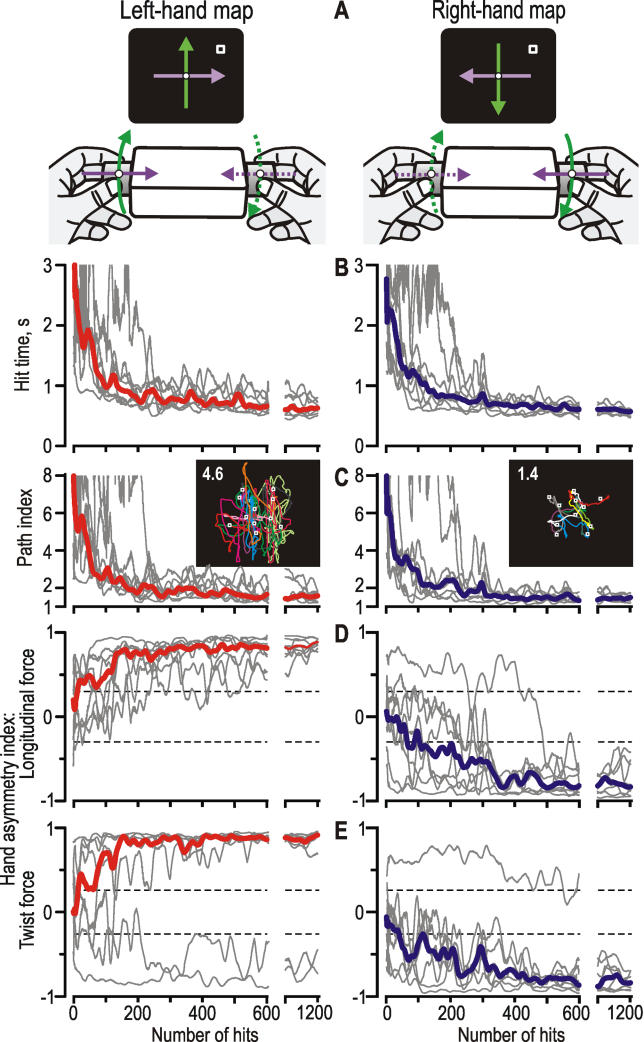
The Bimanual Target-Chasing Task and Flexible Role Assignment of the Hands(A) Mappings between applied forces and cursor movements (top graph). With the left-hand map, the cursor moved horizontally in the direction of the longitudinal force applied by the left hand (solid purple arrows). A counter-clockwise twist force applied between the handles (as if unscrewing the lid of a jar) moved the cursor upward (solid green arrows). With the right-hand map the cursor moved in the opposite directions and thus in the direction of the forces of the right hand.(B and C) Performance under each mapping rule shown for a complete first session with 602 hits and from the last 100 hits of a second session. Superimposed thin lines show hit time and path index for each participant as a function of target number (data median-filtered over a ± 10-s period around each hit). Solid curve give medians across participants. Inserts in (C) exemplify cursor trajectories with a median path index of 4.6 and 1.4 across 10 target transitions. The targets, distributed about uniformly over the screen, were located 5.1 ± 2.1° (mean ± 1 SD) visual angle from its center, which corresponded to 2.2 ± 0.3 N force applied tangentially to the surfaces of the handles.(D and E) Hand-asymmetry indices computed for a sliding ± 10-s time window. Horizontal lines give the upper and lower 95% confidence limit of the index, postulating that hand selection would have occurred randomly. A significant positive and negative index indicates left and right-hand primarily acting, respectively.